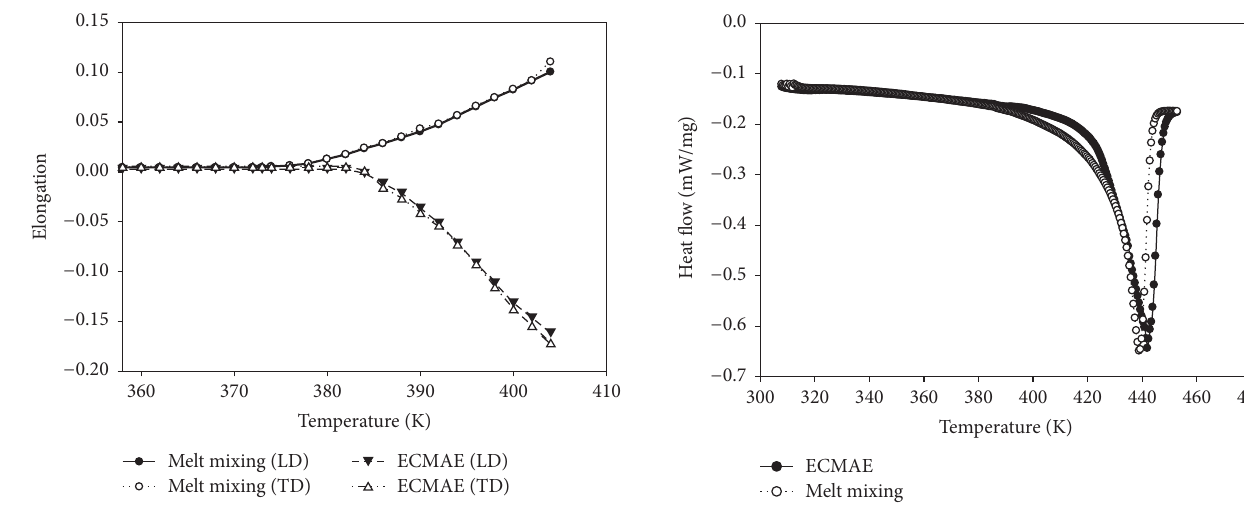
Figure 5: Temperature dependencies of the elongation of the PP- OMMT. LD is the longitudinal direction; TD is the transversal one.